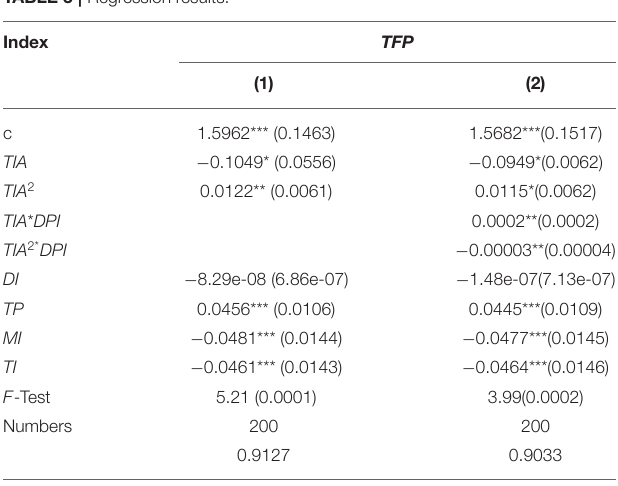
TABLE 3 | Regression results.